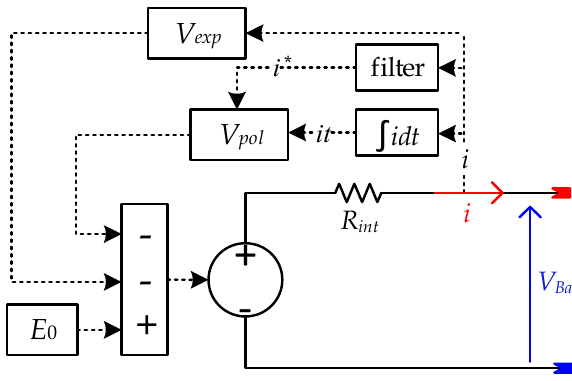
Figure 1. Lead-acid battery discharging model.